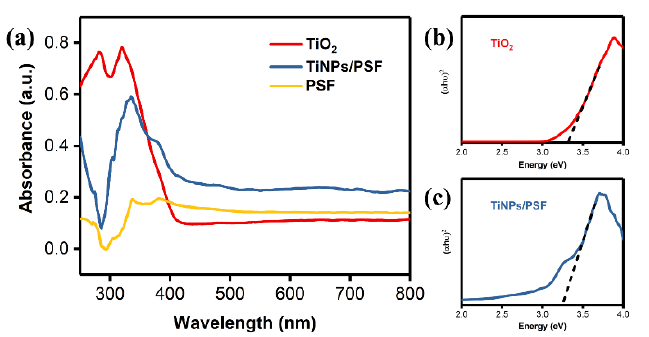
Figure 4. UV–vis diffusion reflection spectra (UV-DRS) spectra of pure PSF, pure TiO 2 , and the TiNPs/PSF composite microsphere ( a ). Tauc plots of TiO 2 ( b ) and the TiNPs/PSF composite microsphere ( c ).